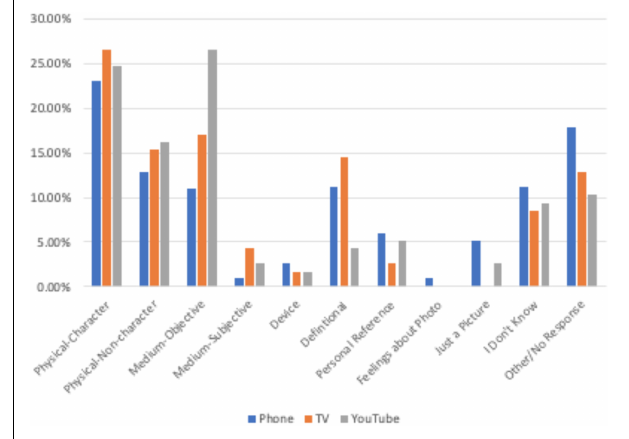
FIGURE 3 | Percentage of children providing each justification by medium.